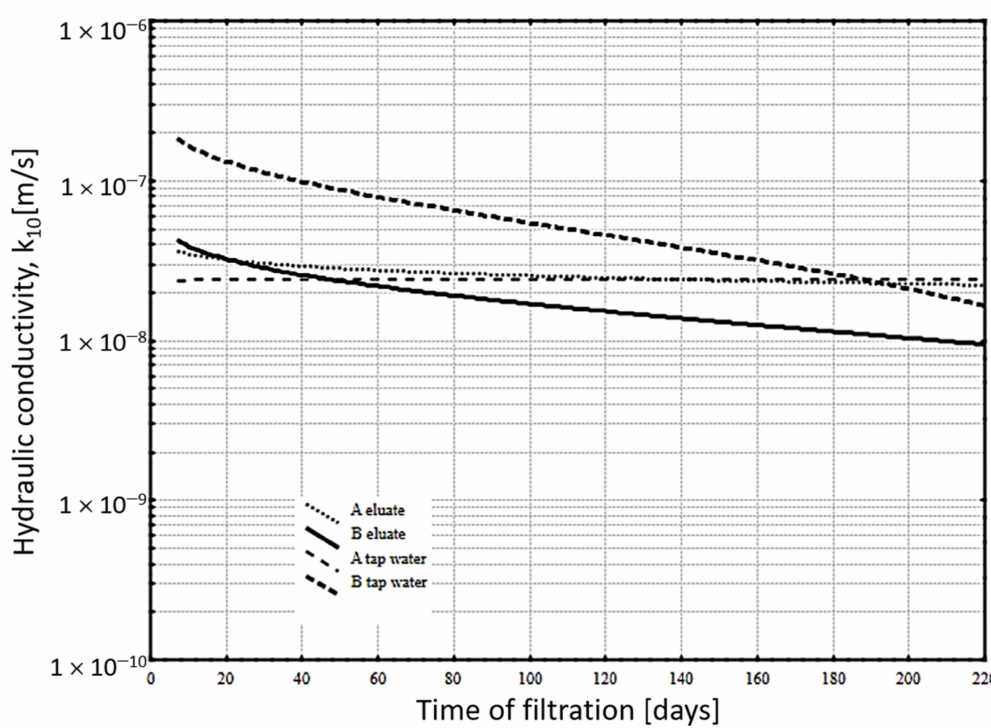
Figure 2. Hydraulic conductivity of hardening slurries with addition of fluidized-bed hard coal A and brown coal B fly ash-as a function of time (trend lines).